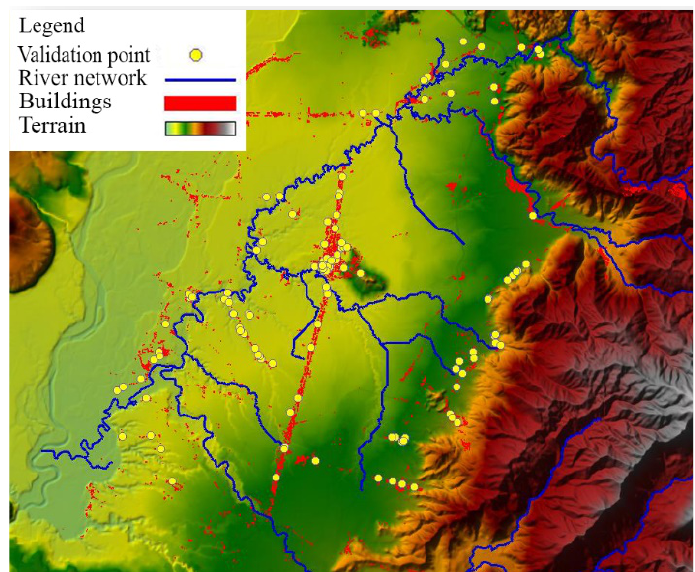
Fig. 2: Validation points in the floodplain of the watershed